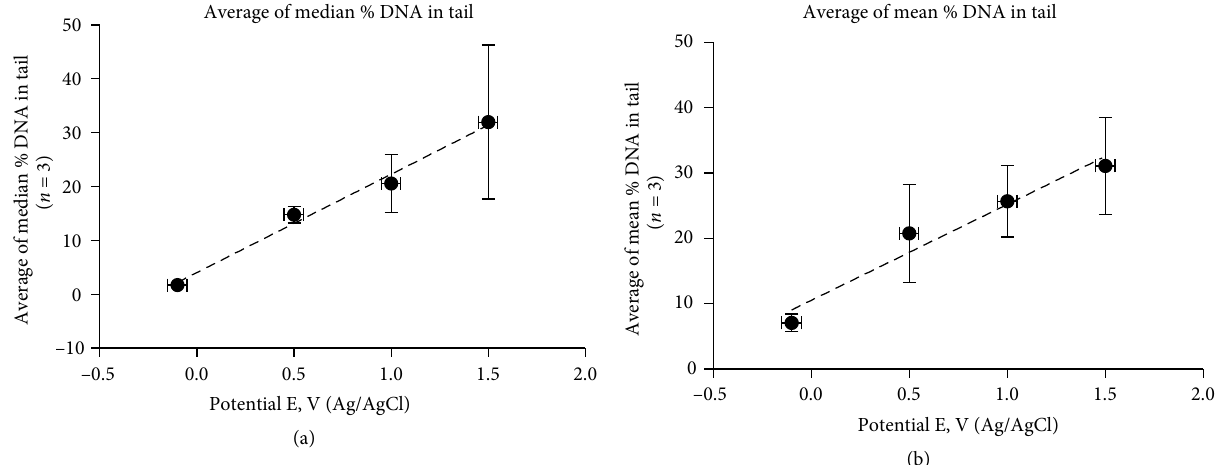
Figure 6: Comparison of comet analyses by median and means averages of % DNA in tail. (a) Plot of average of the comet assay medians as a function of increasing treatment level. Each data point at a given treatment level is the average of the medians of 3 independent comet distributions (histograms shown in Supplementary Figure S2). Error bars represent the standard deviation of the medians at each treatment level. (b) Plot of average of the comet assay means as a function of increasing treatment level. Each data point at a given treatment level is the average of the means of the same 3 independent comet distributions (histograms shown in Supplementary Figure S2). The vertical error bars represent the standard deviation of the medians or means at each treatment level. The horizontal error bars represent the small instrument uncertainty in the applied